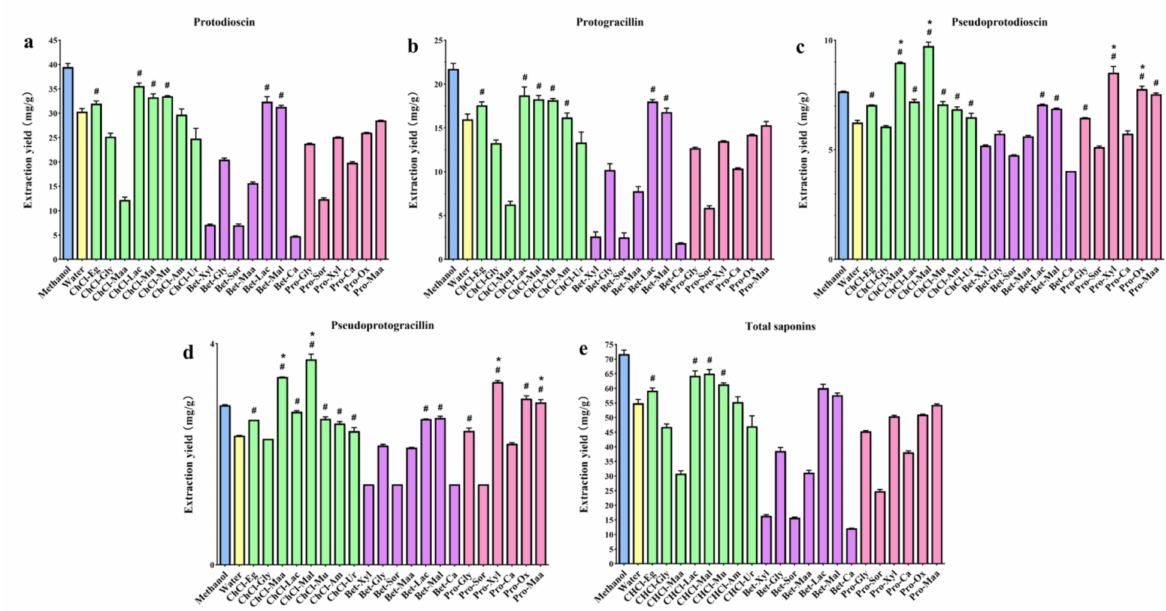
Figure 2. Extraction yields of different solvents for ( a ) protodioscin, ( b ) protogracillin, ( c ) pseudoprotodioscin, ( d ) pseudo- protogracillin, and ( e ) four total steroidal saponins. Error bars indicate the standard deviations ( n = 3). Extraction yields of NADESs compared with water are indicated with # p < 0.05, mean value > water and * p < 0.05, mean value >